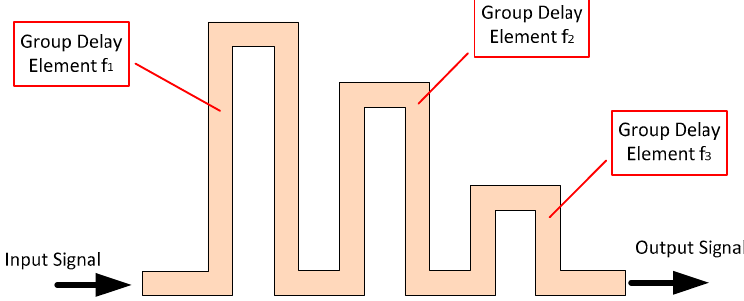
Figure 4. Group Delay Tag Copper Element—Adapted from Reference [52].